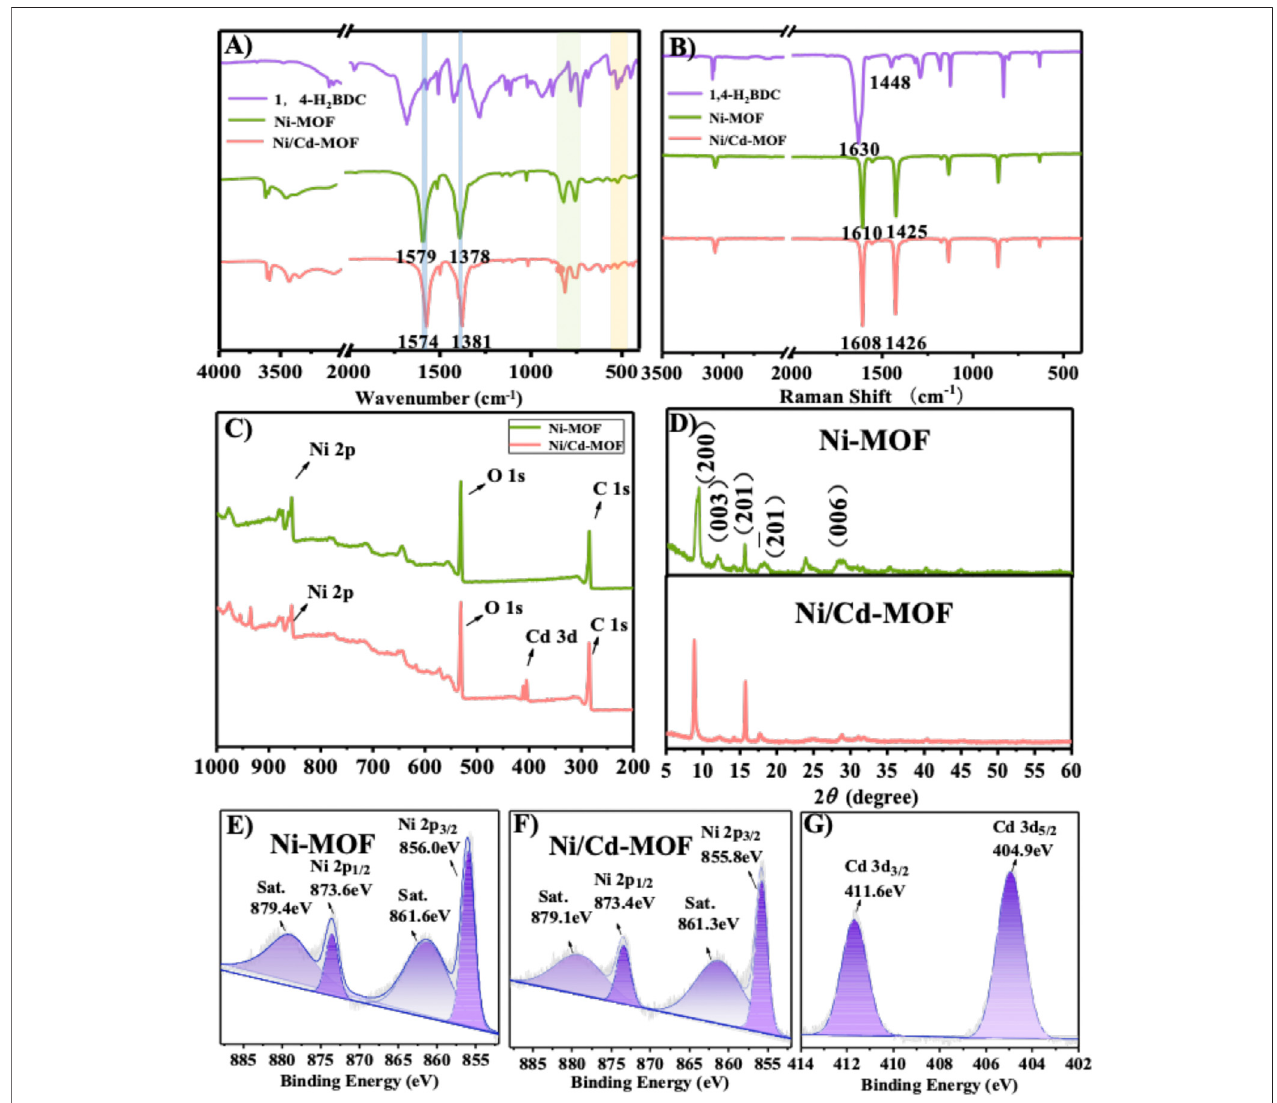
FIGURE2|(A) FTIRand (B) RamanspectraofNi-MOF,Ni/Cd-MOF,and1,4-H 2 BDC; (C) XPSfullspectraofNi-MOFandNi/Cd-MOF; (D) XRDpatternsofNi-MOF and Ni/Cd-MOF; (E) Ni 2p spectra of Ni/MOF; (F) Ni 2p; and (G) Cd 3d spectra of Ni/Cd-MOF.